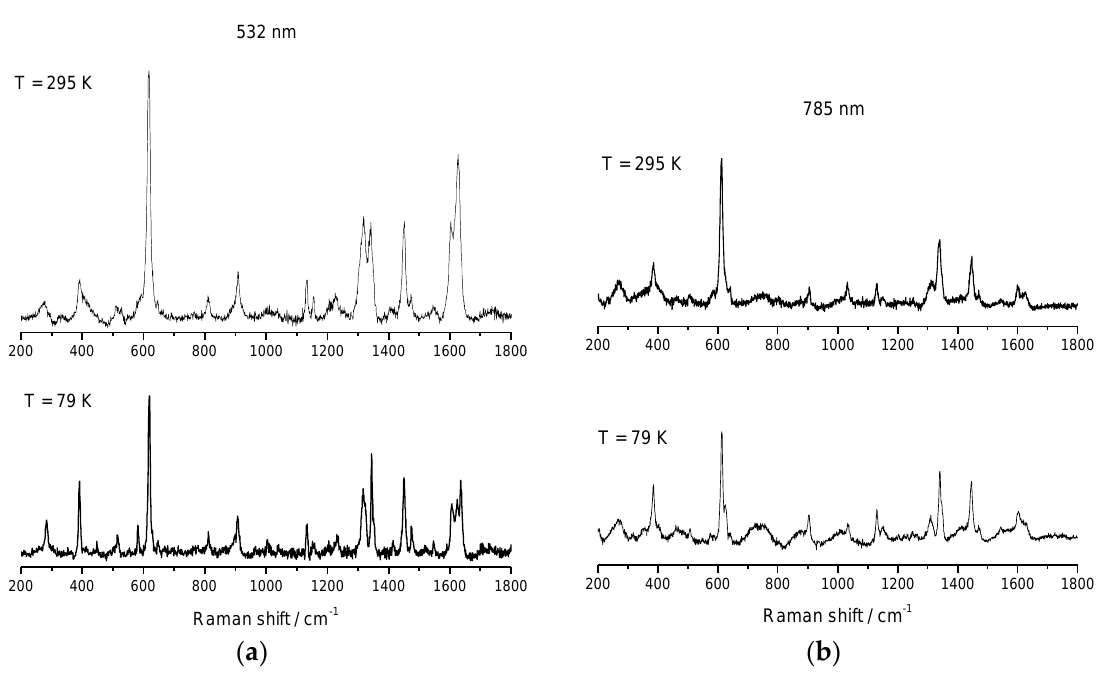
Figure 10. Variable temperature rRaman spectra of [FeL 1C12 ]BF 4 , 2 , using laser excitation of 532 nm ( a ) and variable temperature Raman spectra of [FeL 1C12 ]BF 4 , 2 , using laser excitation of 785 nm ( b ) [52].